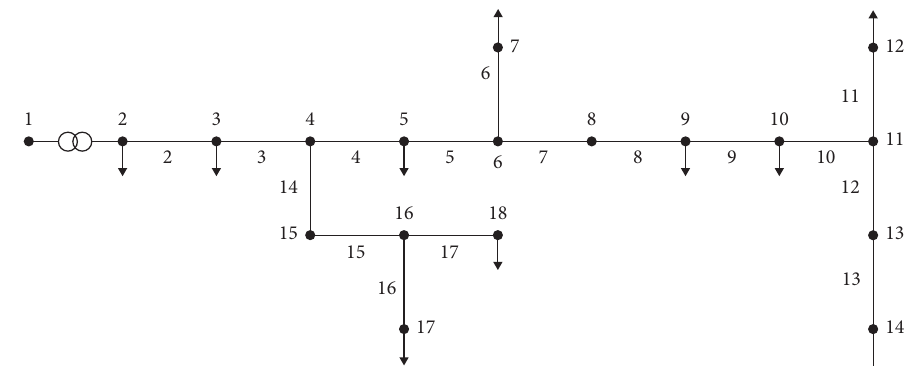
Figure 2: 18-node test network.